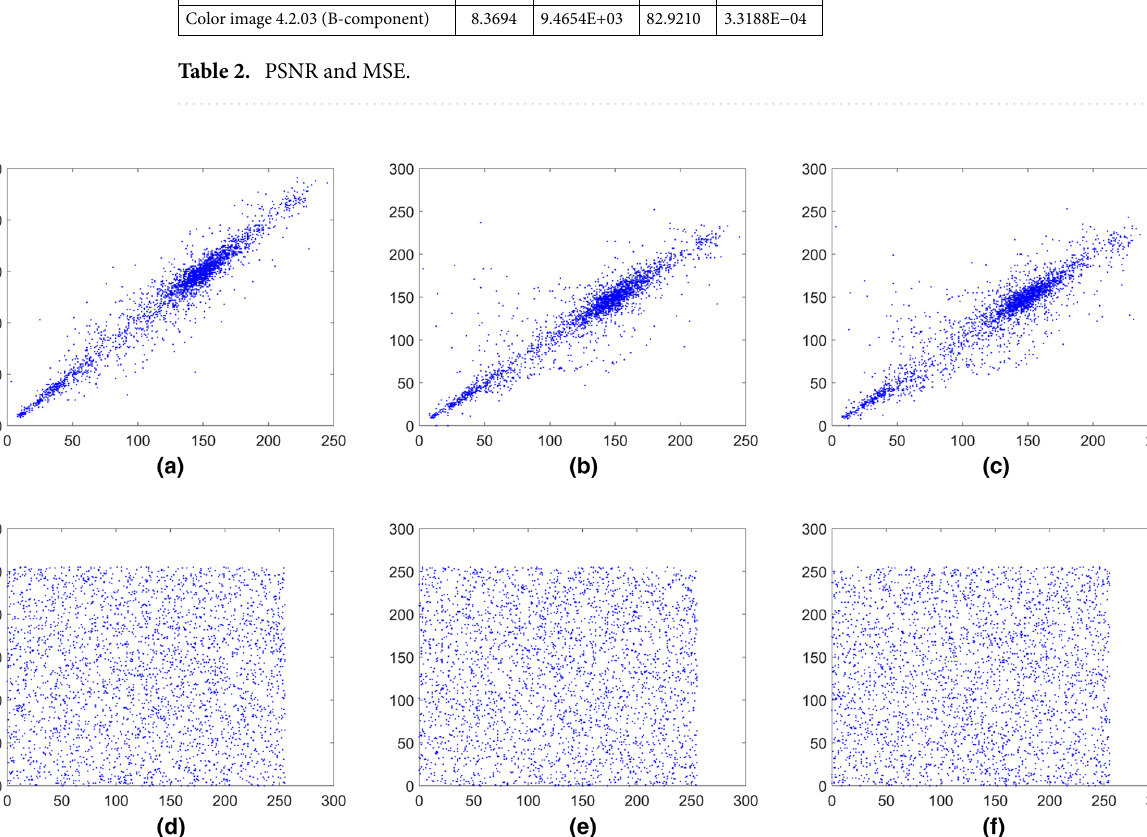
Table 6. The experimental results show that the decrypted image can still display the main information of the original image, so the algorithm is anti attack. Speed performance. The implementation environment of the proposed algorithm is Visual Studio 2019 (Visual C++) with Windows 10 Professional operating system. The specific configuration is Intel Core 2.8 GHz CPU, 8 GB RAM and 1000 GB hard disk. At the same time, MATLAB 2018 (a) is used to plot some graphs. The average running speed of encryption is 0.925 s and the encryption time of other encryption schemes 7,14,25,33 is